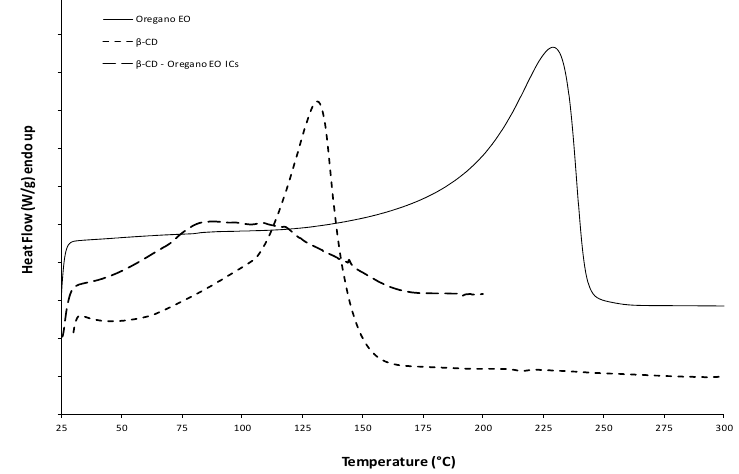
Figure 1. The DSC curves of the oregano EO, β -CD and β -CD—oregano EO ICs.